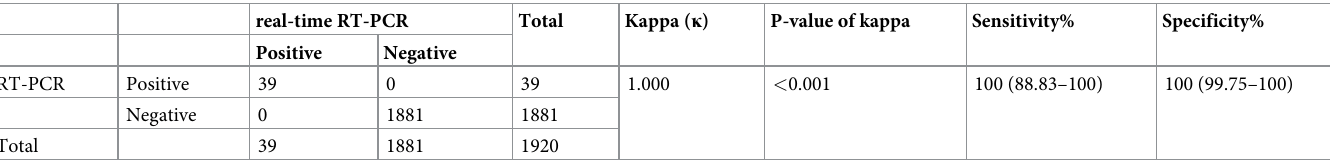
Table 4. Detection results of aMPV in avian clinical